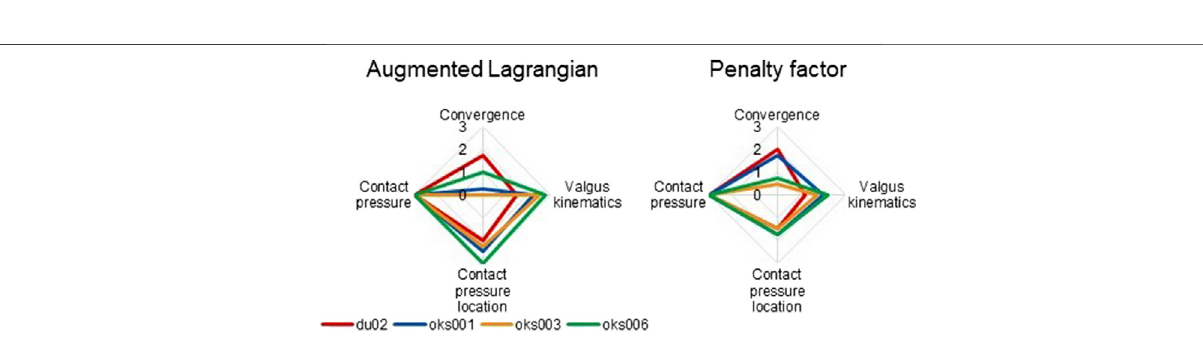
Frontiers in Bioengineering and Biotechnology |